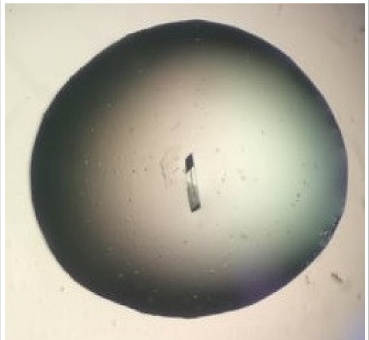
Figure 9. Ribonuclease A crystal growing on bioglass at metastable conditions (drop volume after equilibration ca. 1 µ L; crystal visible to the right of the faintly visible bioglass